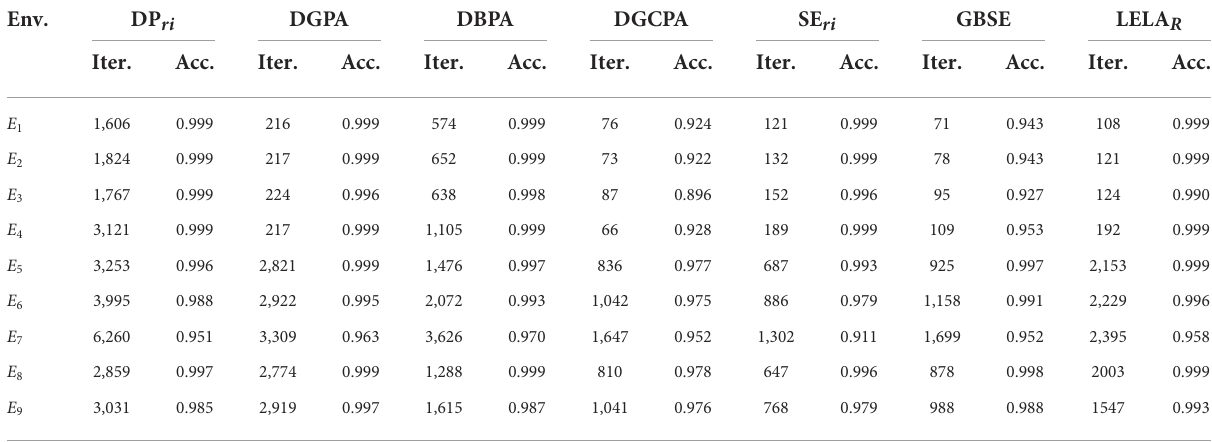
TABLE 7 Comparison of the average number of iterations required for convergence of the parameter-based algorithms in environments E 1 to E 9 . Env. DP ri DGPA DBPA DGCPA SE ri GBSE LELA R Iter.